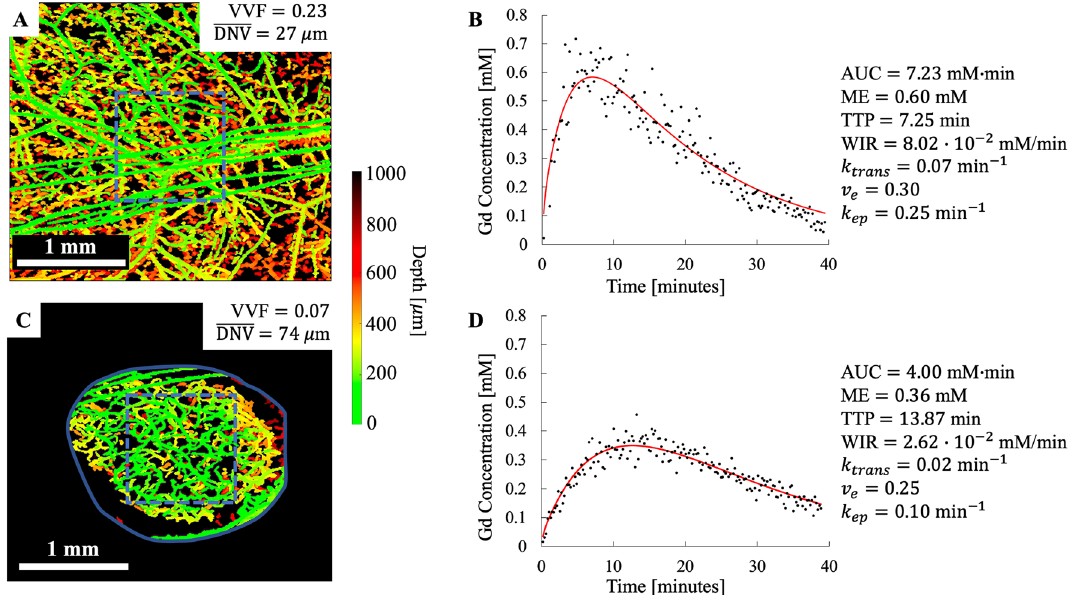
Figure 4. Healthy vs. tumor tissue quantification by svOCT and DCE-MRI. Significant differences in the microvasculature and corresponding DCE-MRI concentration–time curves were observed when comparing healthy and tumor tissue. ( A) segmented depth-encoded svOCT microvascular map of healthy (bare skin) mouse and corresponding DCE-MRI Gd time concentration curve ( B ). ( C) and ( D) present analogous results for a tumor-bearing mouse. Gd time concentration curves and svOCT vascular metrics were calculated within a 1 mm 3 volume of interest (blue dotted line) shown in ( A) and ( C) . The solid blue line in ( C) shows the tumor contour and the red line in ( B) and ( D) are the Toft’s model fits to the data. ( A) and ( C) were generated using MATLAB R2020A software (MathWorks, Inc., Natick, MA,